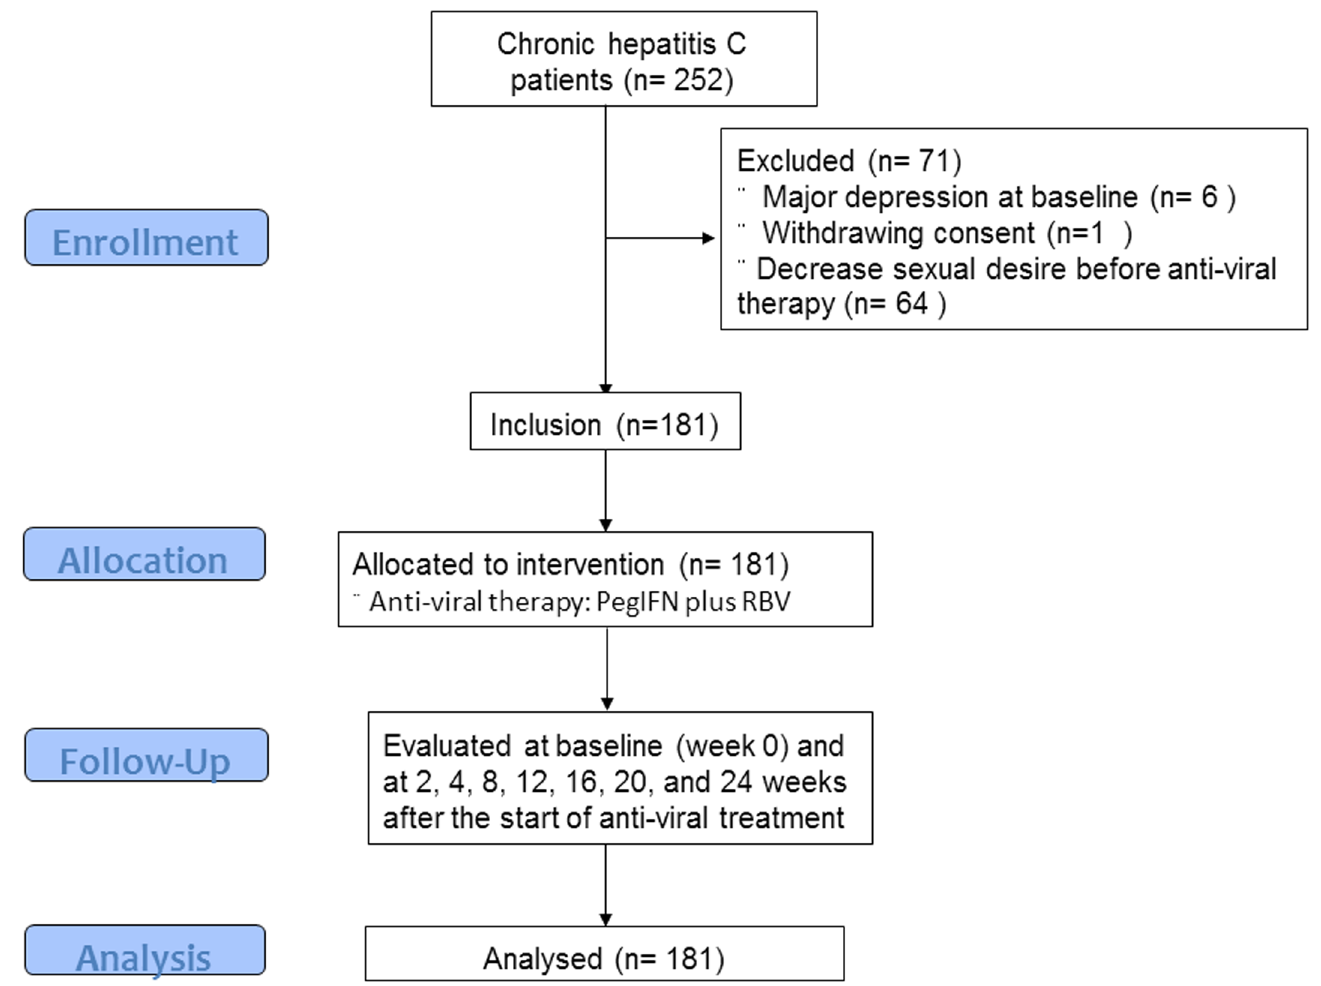
Fig 1. Flow chart of included patients in the